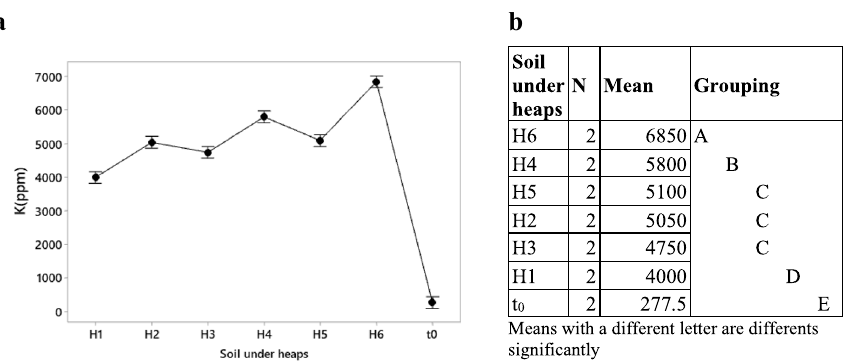
Fig. 6 Statistical tests related to K content under the soil (p<0.05) : a confidence intervals related to K means under the soil before ( t 0 ) and after composting (under H1 to H6) ( one-way ANOVA test ); b Tukey test associated